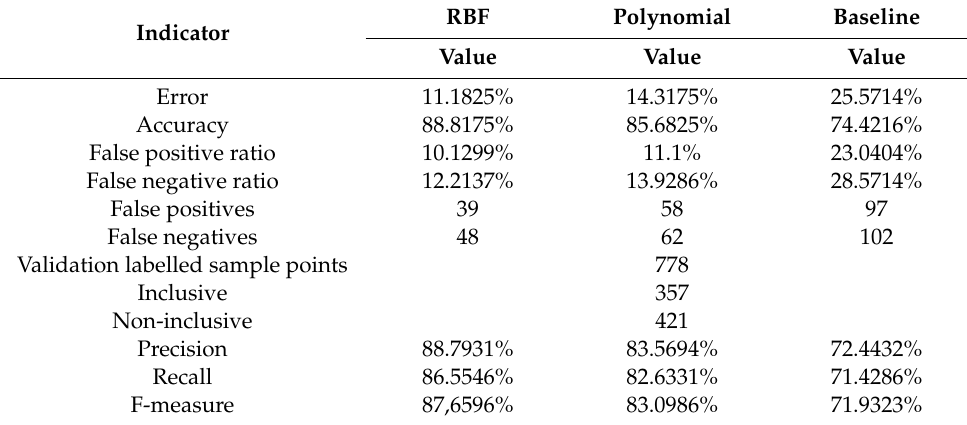
Table 11. Evaluated performance.